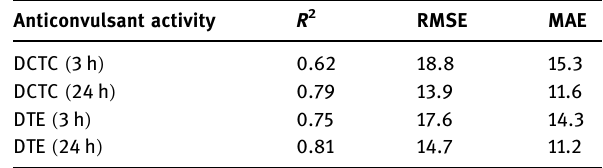
Table 3: The statistical characteristics of consensus models ( test set